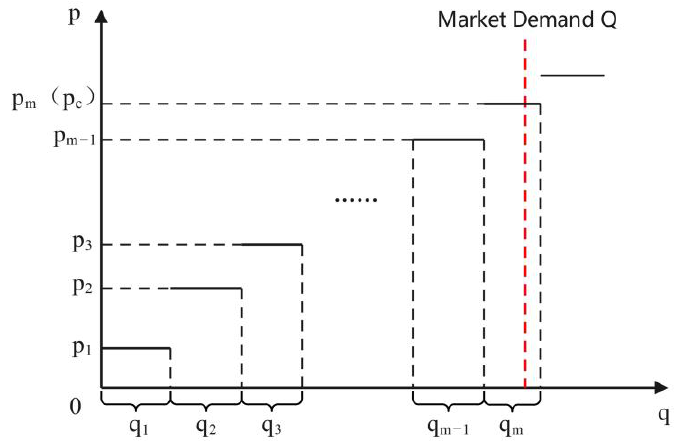
Figure 2. PAB, MCP pricing mechanism schematic.